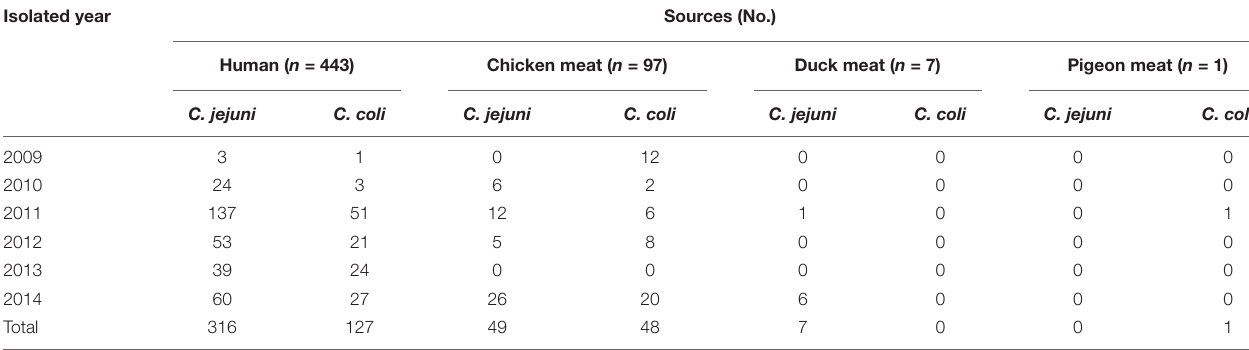
TABLE 2 | Primers for the identification of antimicrobial resistance genes of the multidrug resistance Campylobacter jejuni and Campylobacter coli. Antimicrobial resistant gene